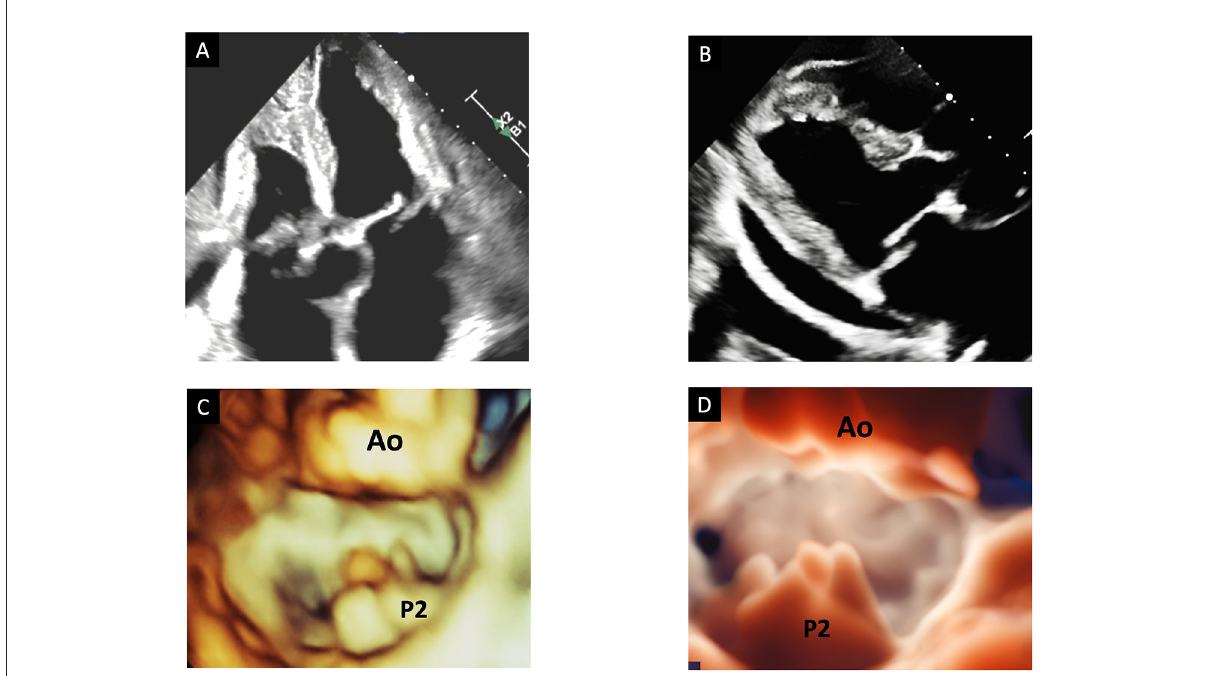
FIGURE3 The advantage of transillumination rendering in 3DE. Top panels show an example of P2 flail by 2D TTE with evident eversion of the scallop in a 4-chamber view (A) and in a long-axis view (B) . Bottom panels show 3D TTE surgical views of the mitral valve by standard 3D reconstruction (C) and by TI rendering (D) . Only TI clearly shows the entire P2 scallop prolapsing in the left atrium with multiple chordal ruptures. 3D, three-dimensional; TEE, transesophageal echocardiography; TI, transillumination. TTE, transthoracic